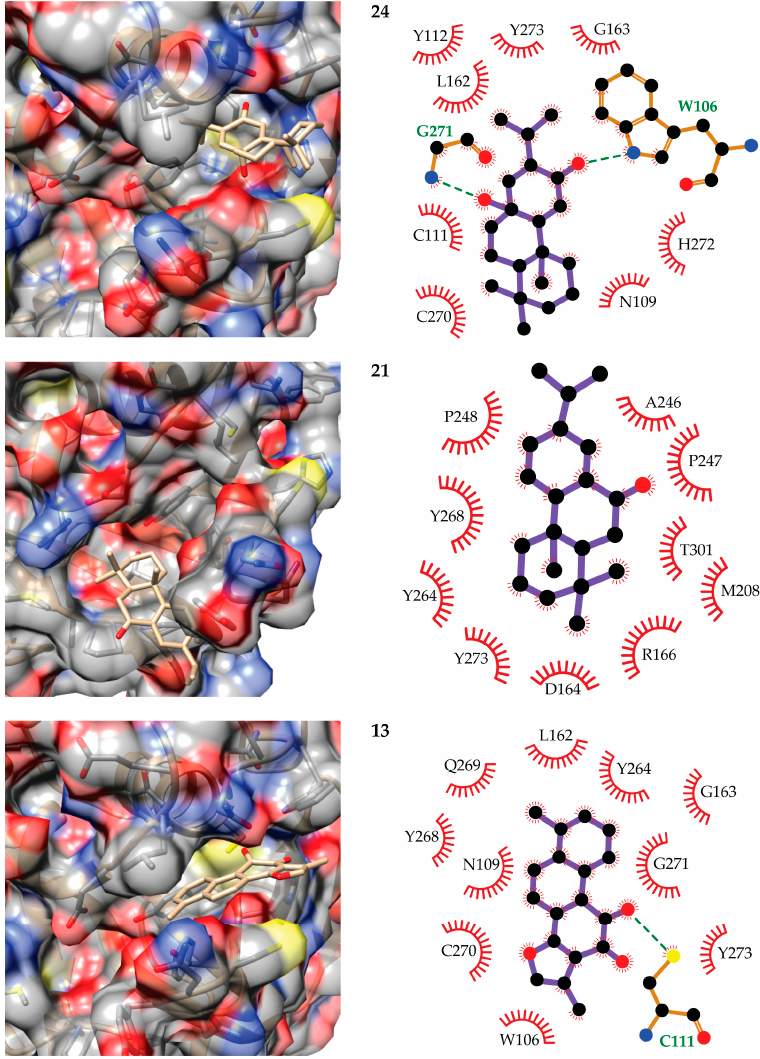
Figure 5. Predicted binding modes of 24 (8- β -hydroxyabieta-9(11),13-dien-12-one) , 21 (dehydroabieta-7-one), and 13 (tanshinone I, bottom) to the SARS-CoV-2 PL pro (left) and diagrams of the observed ligand–receptor interactions (right). The receptor surface is colored by atom type: gray for carbon, red for oxygen, yellow for sulfur, and blue for nitrogen. All atoms are represented only for amino acids forming hydrogen bonds with the ligands in the interaction diagrams. In these, hydrogen bonds are represented by dashed lines, carbon atoms are represented in black, and the rest of the atoms are colored as in the left images.